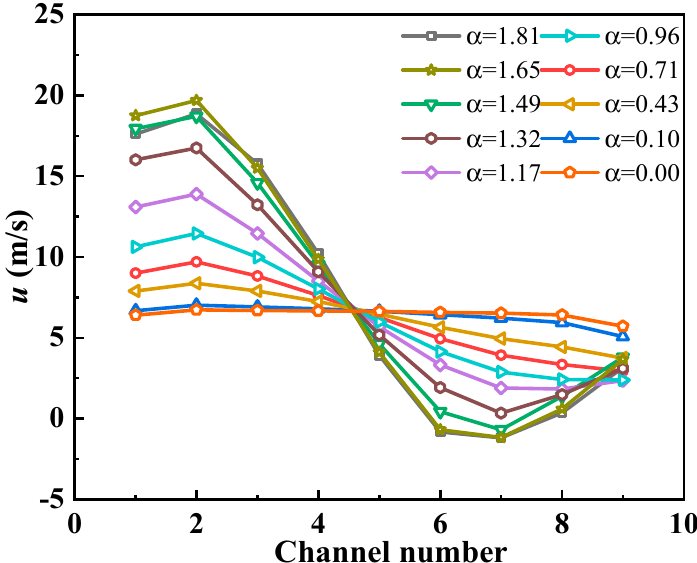
Figure 8. Velocity distributions at nine channels under different maldistribution coefficients.